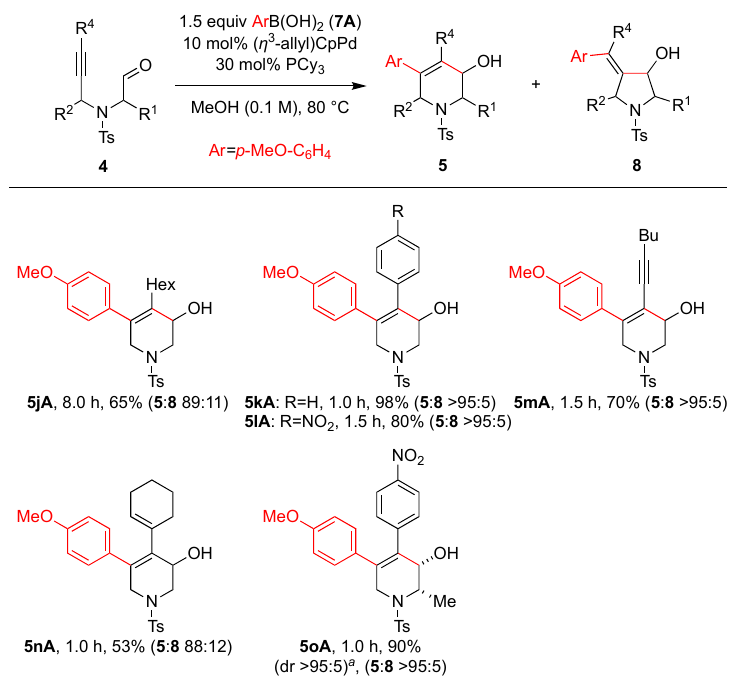
Scheme 4. Tetrahydropyridines prepared by Pd/PCy 3 -catalyzed arylative cyclizations of internal